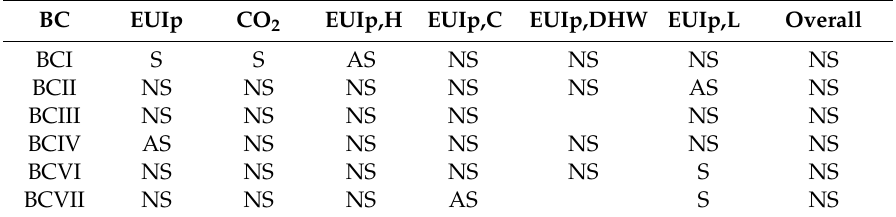
Table 12. Stabilization status for all building